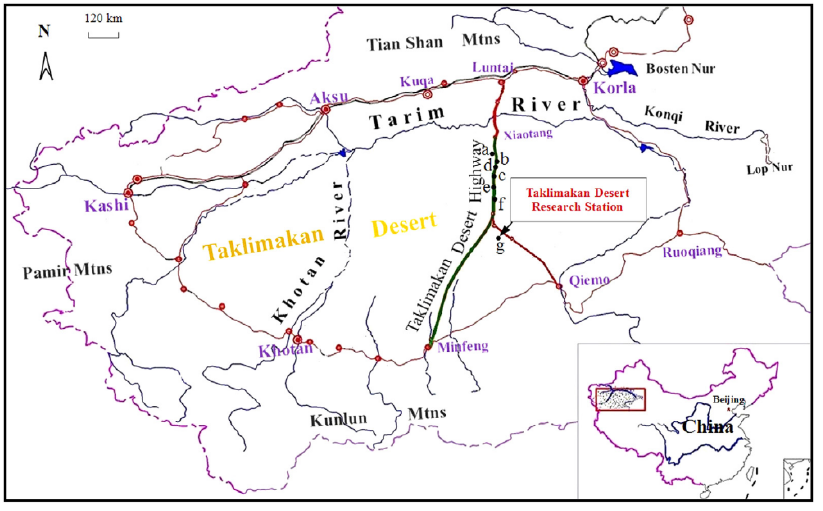
Figure 1. Taklimakan Desert Highway and the monitoring sites.